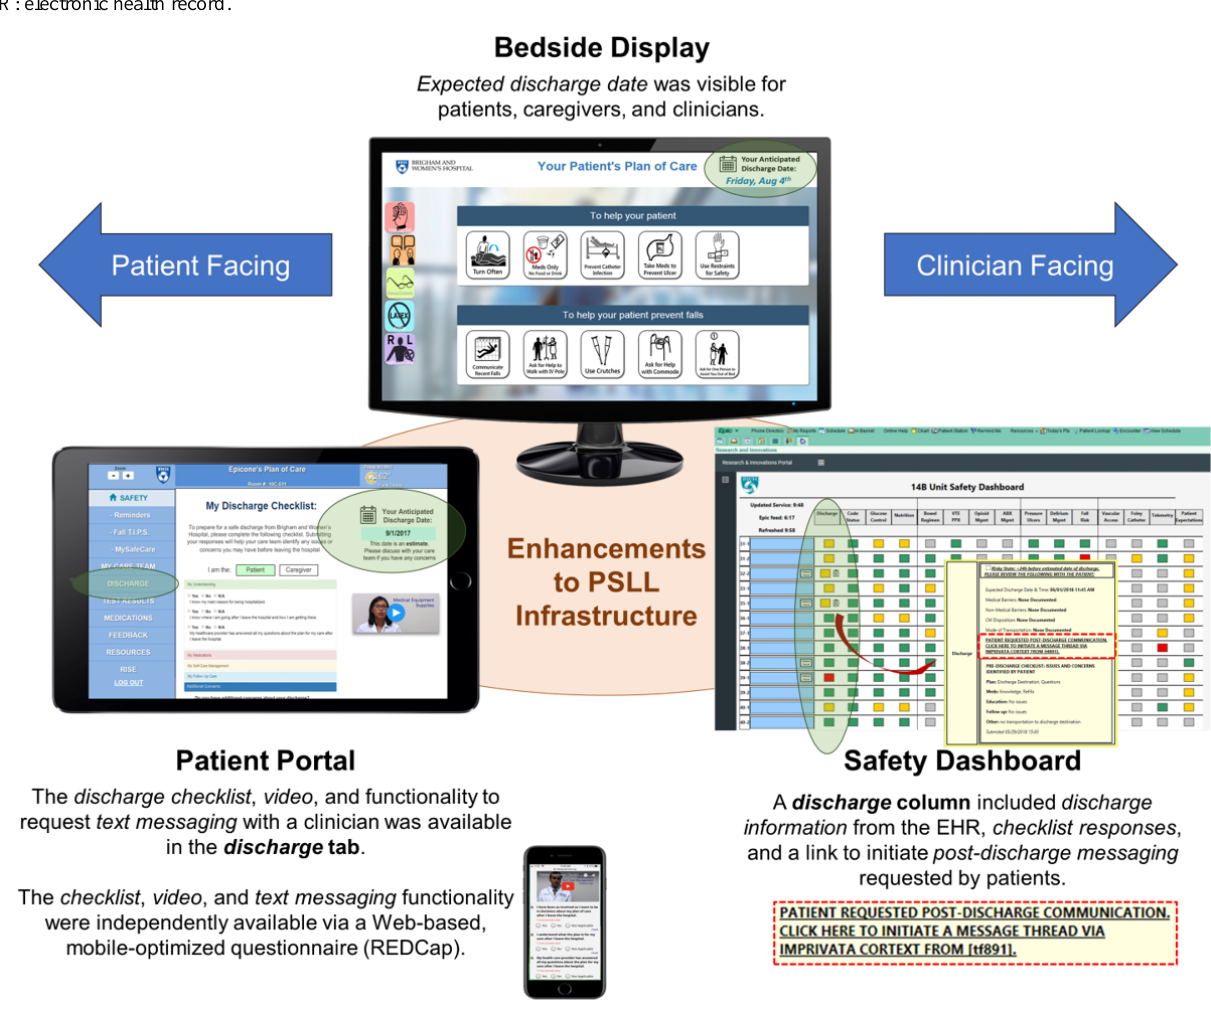
Figure 1. Patient-centered discharge toolkit: Enhancements to the EHR-integrated digital health infrastructure. PSLL: Patient Safety Learning Laboratory; EHR: electronic health